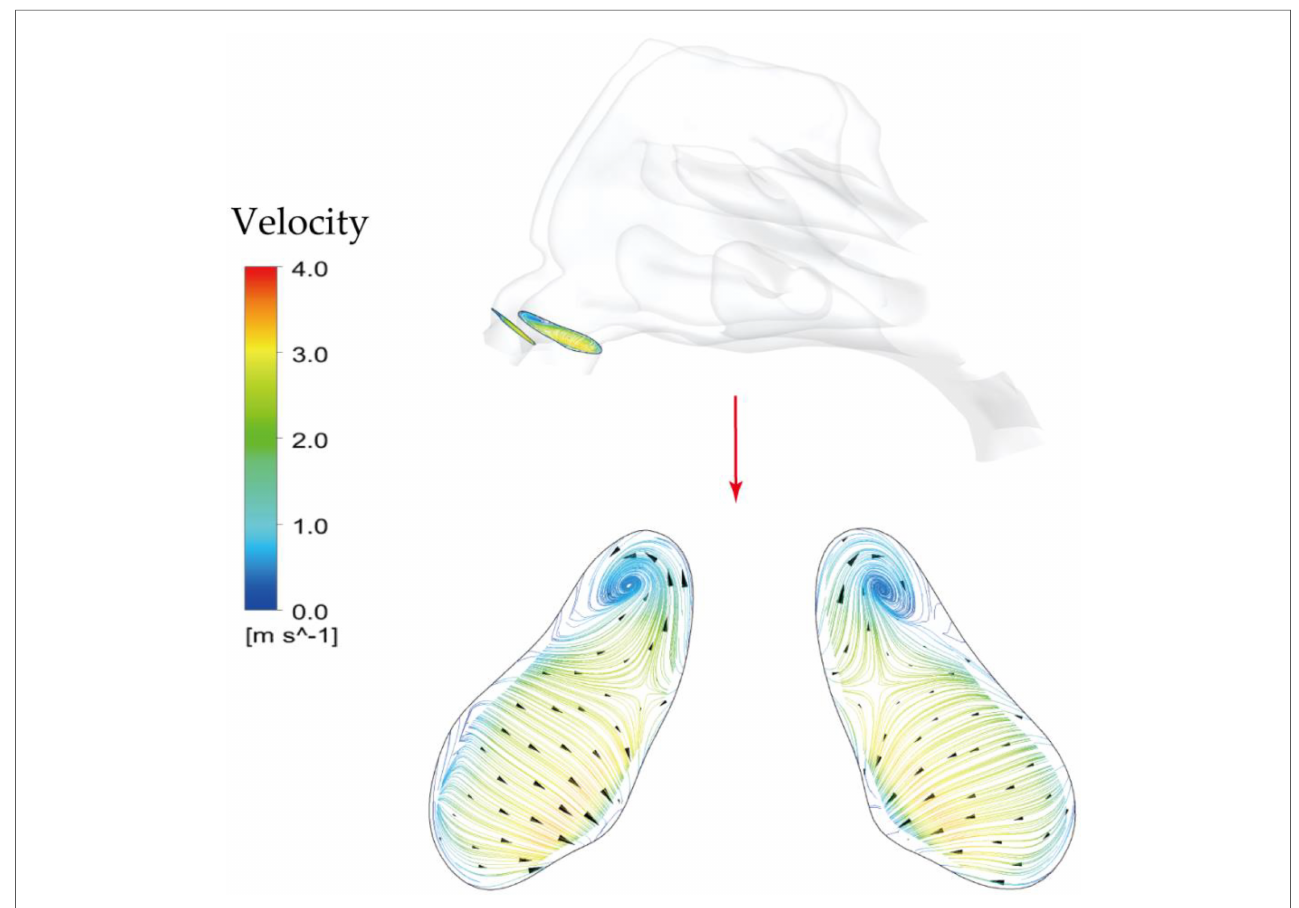
FIGURE 11 Secondary fl ow patterns on a cross-sectional plane in the middle of vestibule region under light exercise inhalation condition (9.5 LPM).